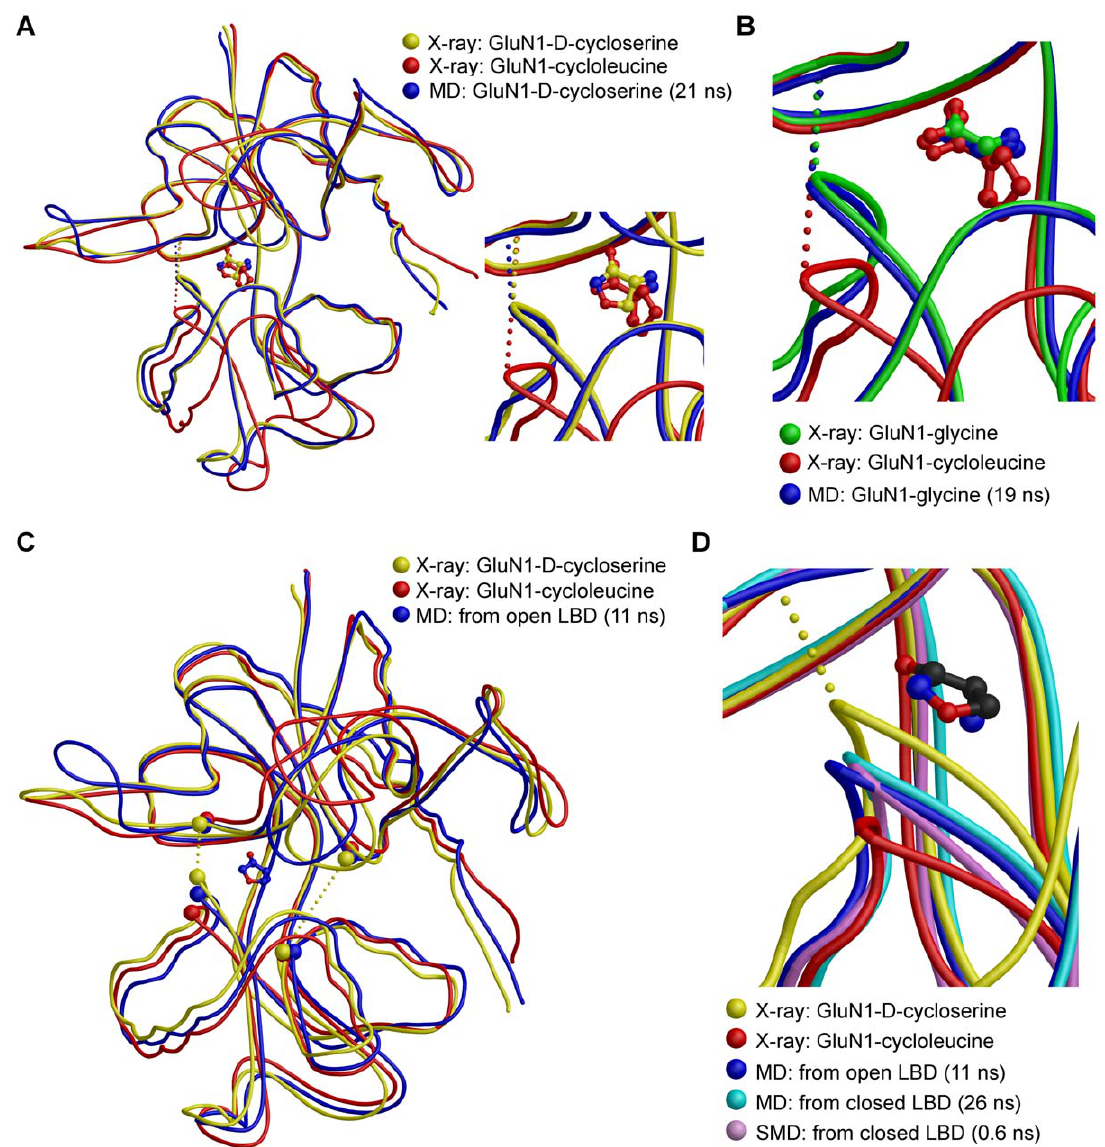
Figure 2. MD and SMD simulations of ligand-bound GluN1-LBD. Free MD simulations indicate that (A) D-cycloserine and (B) glycine bound to open-cleft GluN1 (from PDB: 1Y1M) can close the LBD between D1 and D2, as seen in the crystal structures. (C) Contrary to crystal structures, a stable intermediate closure stage is seen in GluN1-LBD with bound partial agonists. Superimposition of a snapshot from a D-cycloserine simulation in Fig. 3A (blue line) with crystal structures of the same ligand (PDB: 1PB9) and antagonist ligand cycloleucine (from PDB: 1Y1M) is shown. C a atoms of IHB residues (Gly485 and Gln686), as well as of residues Gln405 and Ala715, are depicted as CPK, and dotted lines represent the distances measured to study the closure of the cleft. (D) A close-up of the intermediately closed GluN1-D-cycloserine structures in free MD simulations – starting from both closed and open-cleft structures – as well as in SMD simulation starting from a closed-cleft structure (6 pN, blue line in Figure S2). Crystal structures of GluN1 with bound D-cycloserine (from PDB: 1PB9) and cycloleucine (from PDB: 1Y1M) are superimposed for comparison. Dotted lines in (A), (B), and (D) represent the IHB distance between Gly485 N and Gln686 O , which is an efficient indicator of cleft closure.